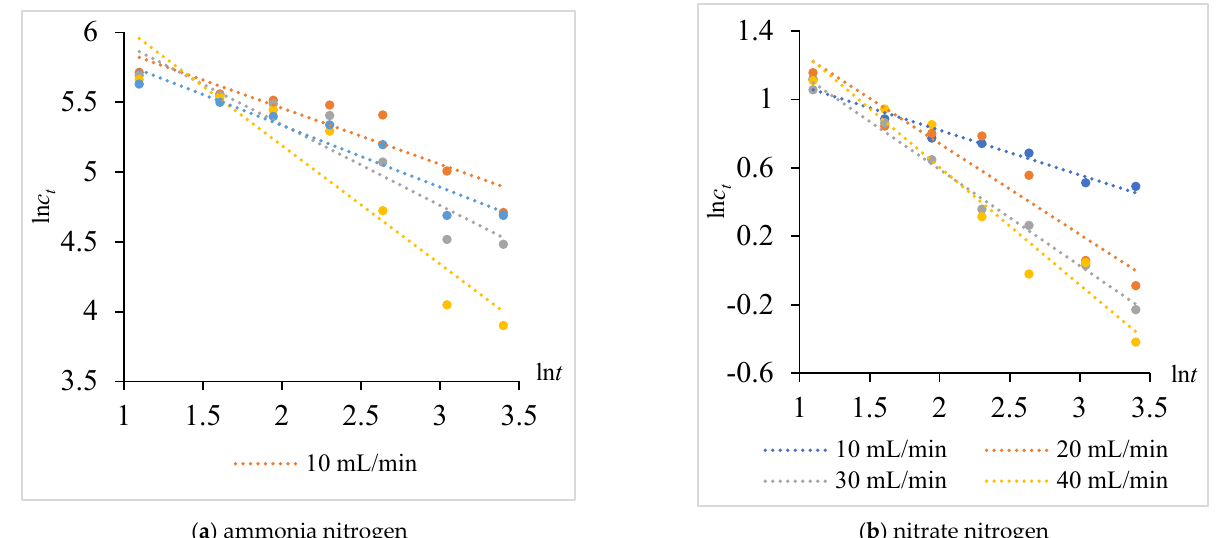
Figure 7. Double logarithm regression relationship between ammonia nitrogen/nitrate nitrogen content in sediment and test days under aeration.